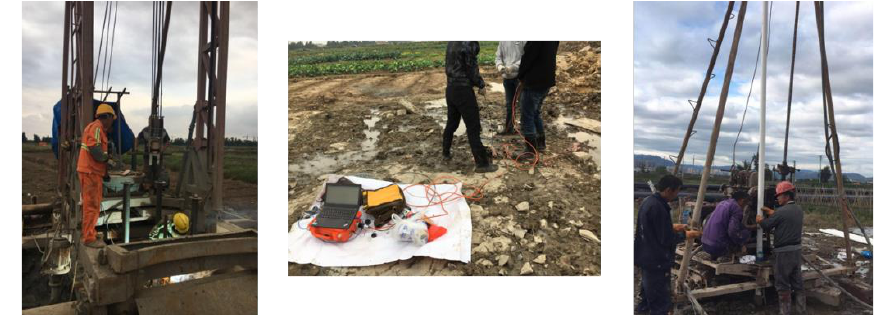
Figure 5. Transmitted wave test in the pile.